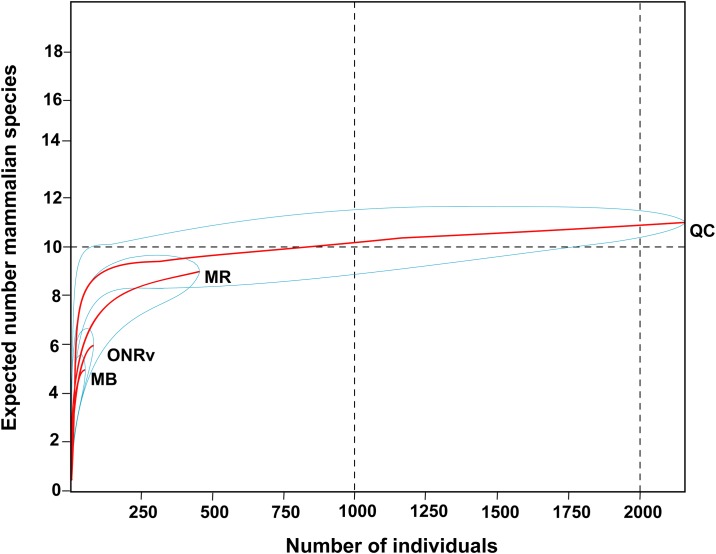
Rarefaction curves of rodent species richness.Comparisons are made among the four geographic zones where rodent trapping was conducted (Manitoba [MB], Ontario Rainy River [ONRv], Quebec [QC] and the Maritimes [MR]) in the richness of rodent communities using rarefaction measurements. Blue lines depict the 95% confidence limits.